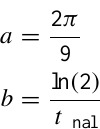
is the last step in ensuring proper verification of the RadBelt